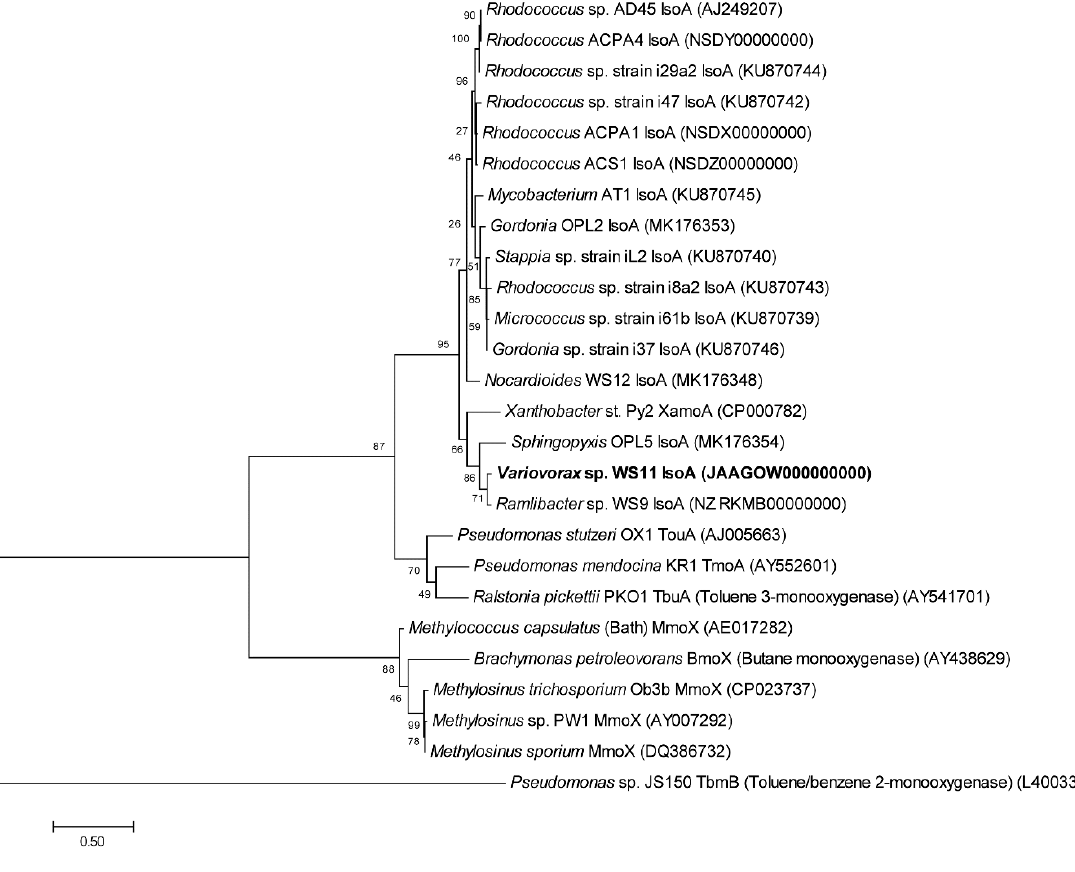
Figure 2. Phylogenetic organisation of isoprene monooxygenase oxygenase alpha-subunit ( isoA ) against reference soluble di-iron monooxygenase (SDIMO) amino acid sequences with accession numbers in brackets. The tree was drawn using the Maximum Likelihood method using Mega7 [77]. Bootstrap values (500 replications) are shown at the nodes. All positions containing gaps and missing data were eliminated. Branch lengths are measured in the number of substitutions per site.